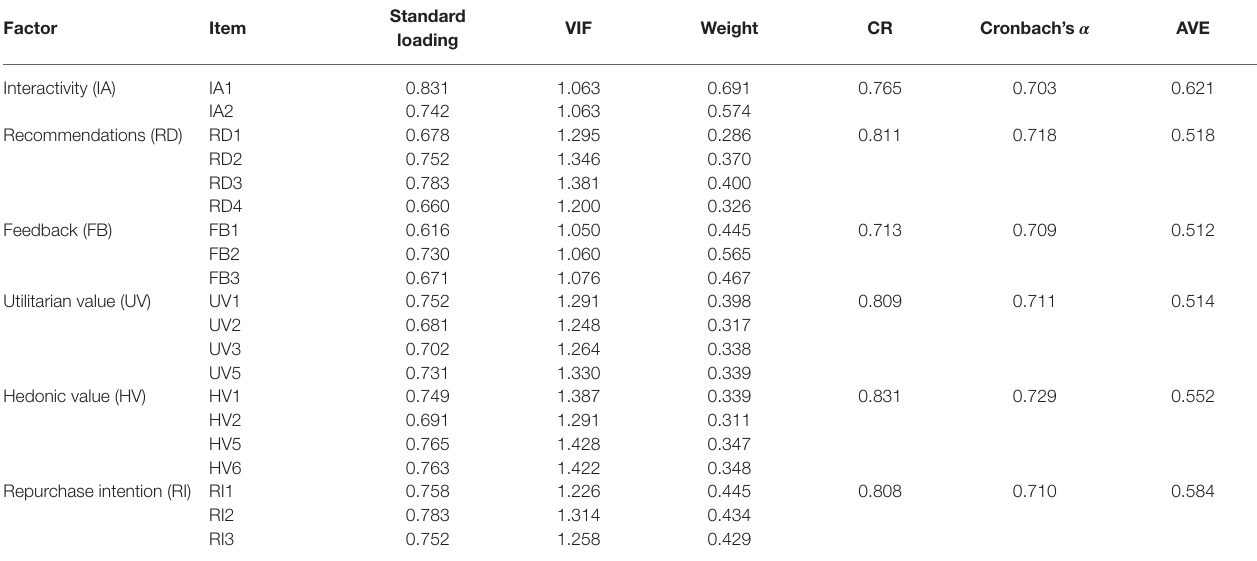
TABLE 3 | Results of reliability and convergent validity analysis. Factor